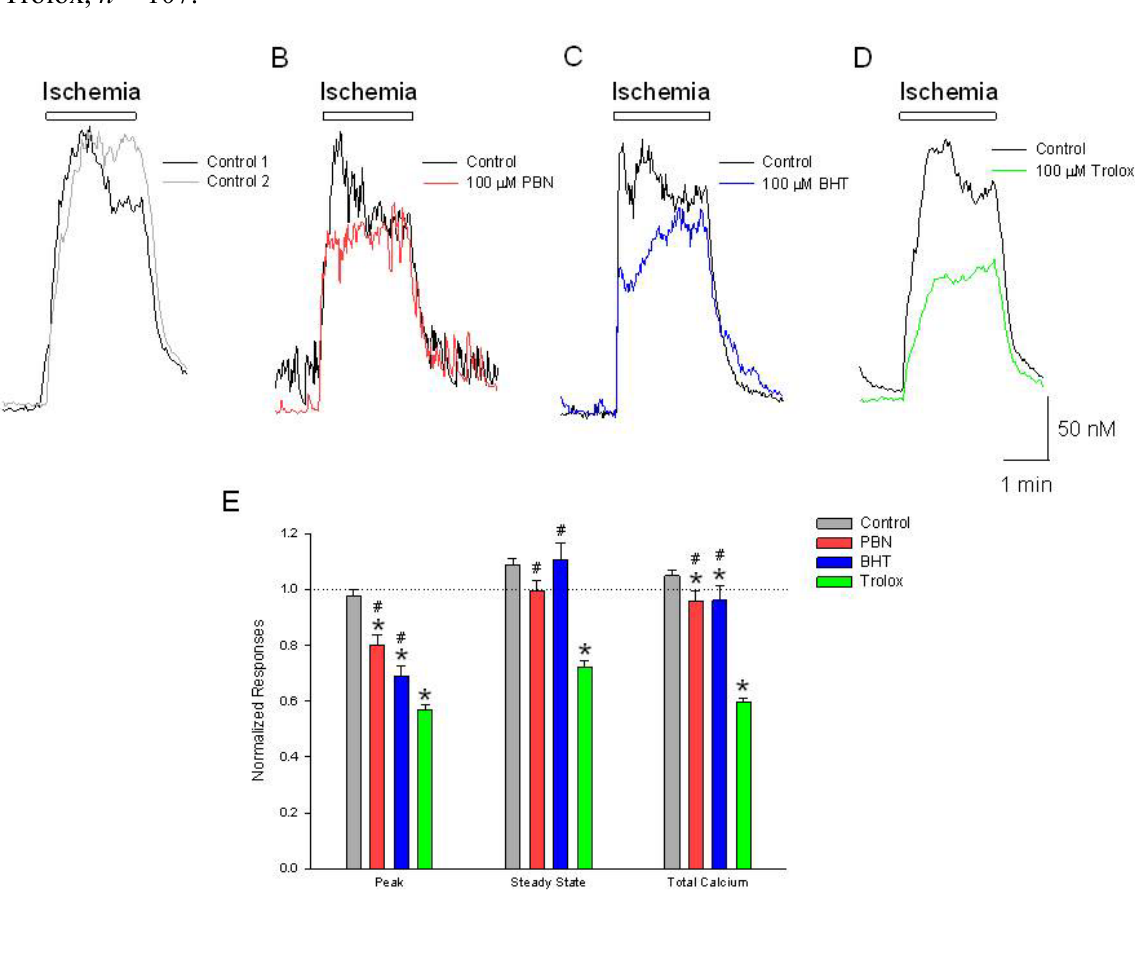
Figure 1. Ischemia produces increases in [Ca 2+ ] , are differentially inhibited by i Phenyl- N -tert-butylnitrone (PBN), butylated hydroxytoluene (BHT) and trolox. Representative traces of [Ca 2+ ] , as a function of time during a ( A ) 2 min application of i NaN in the absence of glucose. The initial ischemia induced elevation in [Ca 2+ ] 3 i (black trace) was reproducible following a 20 min washout period (gray trace); In separate experiments, following the control ischemic responses (black traces), a 20 min